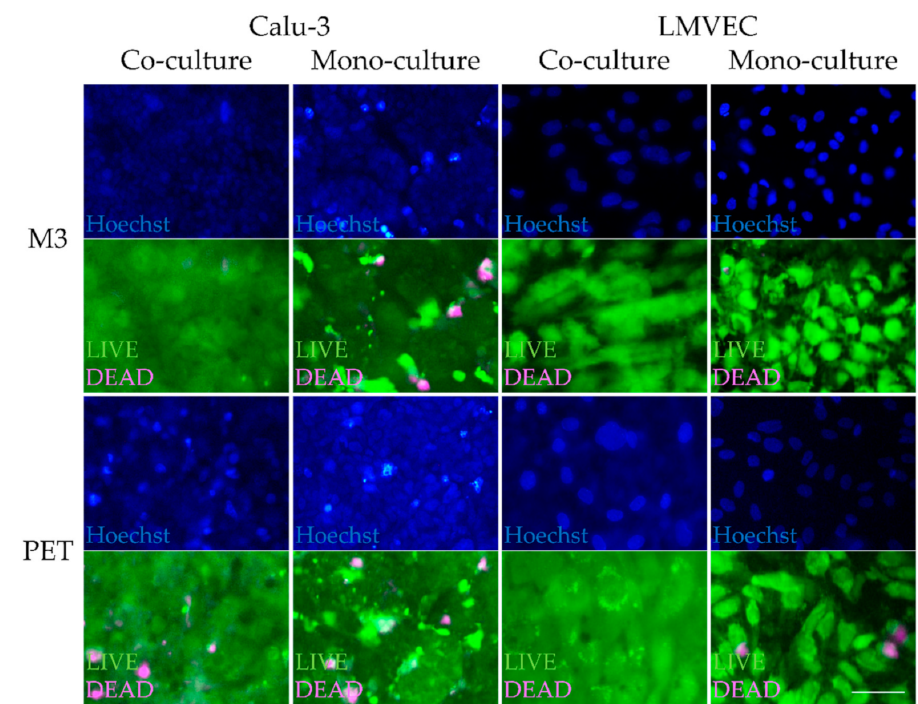
Figure 3. Live/dead staining of co- and mono-cultures of Calu-3 cells and LMVECs on M3 membranes. Cells on inserts with PET membranes served as controls. Calu-3 cells were cultured submerged for 8 days, after which they were cultured at ALI for 2 weeks. LMVECs were cultured submerged throughout the experiment. Images show the cell nuclei (Hoechst: blue), and the living (calcein: green) and dead cells (ethidium homodimer I: magenta). Magnification: 400 × . Scale bar: 50 µ m, applies to all images. Images are representative for observations of samples from two independent experiments (total N =